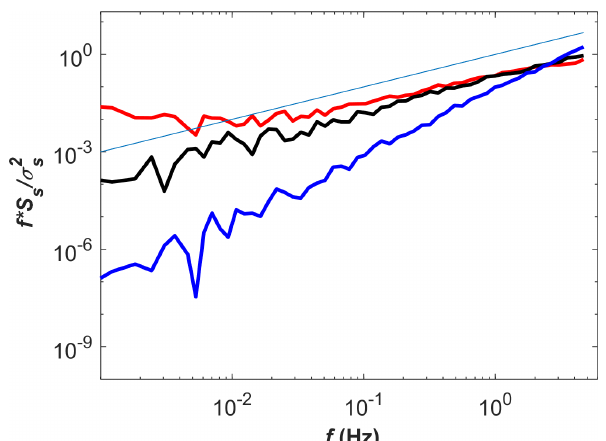
Figure B1. Normalized spectra of methane concentration (red), white noise (black), and blue noise (blue) ( f S s /σ 2 s ), all of which have the same standard deviation. The solid straight line is f + 1